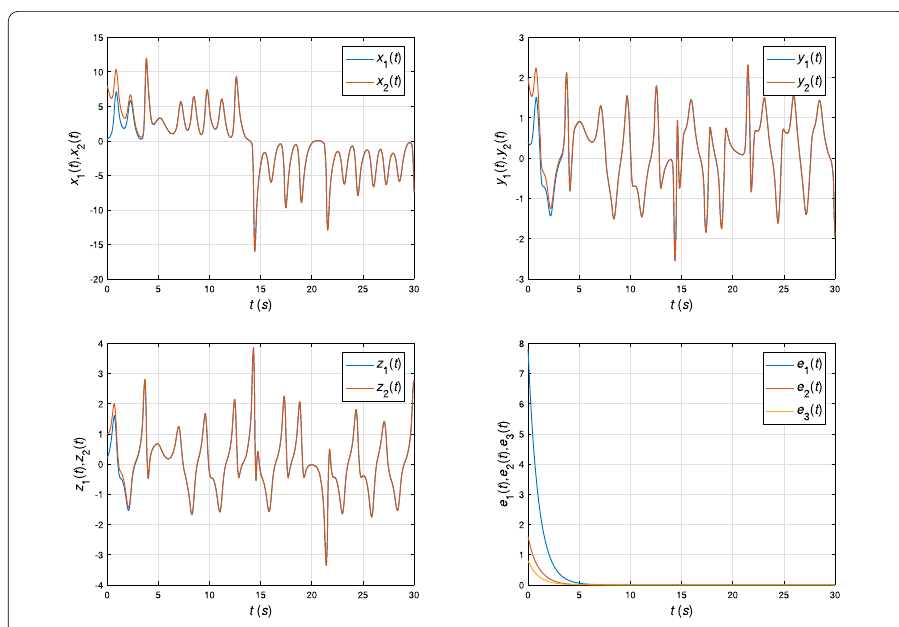
Figure 12 Synchronization results between two nonidentical fractional-order systems (37) and (38) for α 1 = α 2 = α 3 = 1 (integer-order